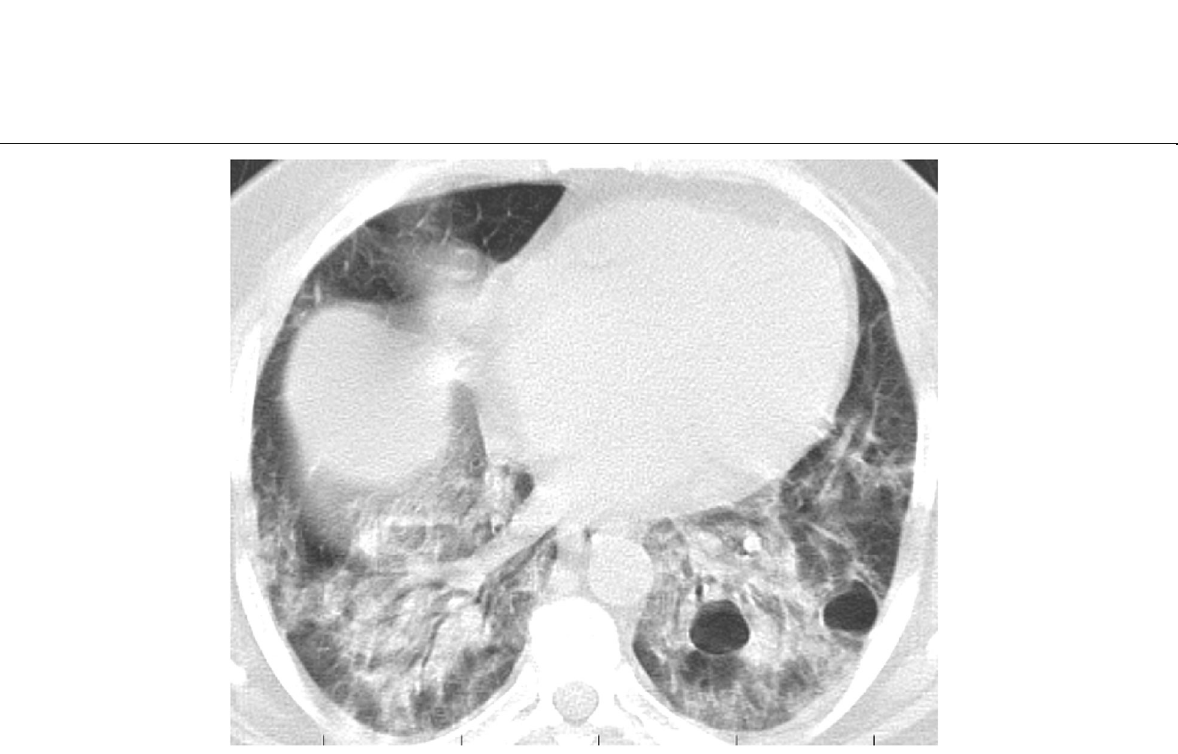
Fig. 20 A 50-year-old male patient with COVID-19. The patient is a known hypertensive and diabetic. CT chest axial image shows bilateral extensive consolidation of both lower lobes with air-bronchogram. Two air – containing lungs cysts are seen in the left lower lobe